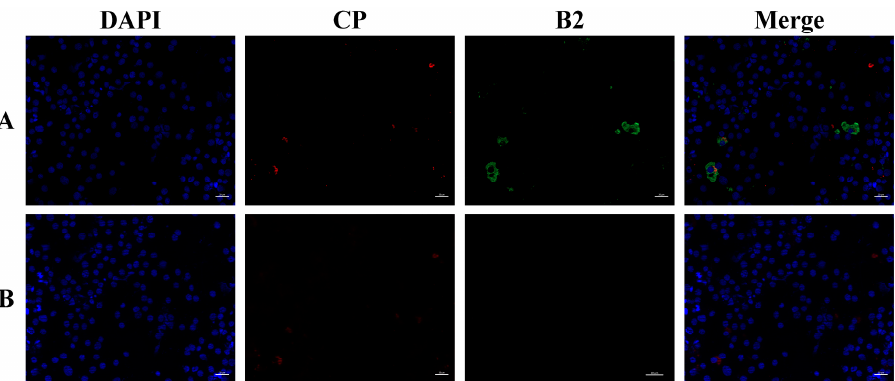
Figure 2. Indirect immunofluorescence results of antibody localization to B2 natural protein in SSN-1 cells infected with NNV. ( A ) Incubation antibody is rabbit anti-B2 protein polyclonal antibody with monoclonal antibody of NNV Cp; ( B ) rabbit negative serum control. Scale bar = 20 µ